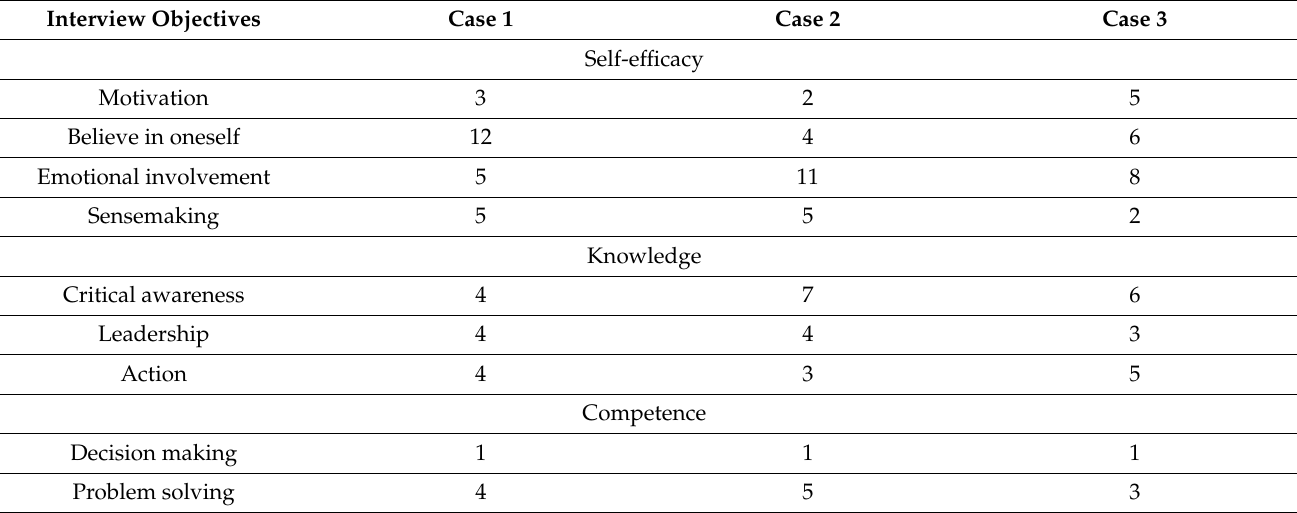
Table 3. Interview objectives. Numbers indicate the frequency of mentioned item by the